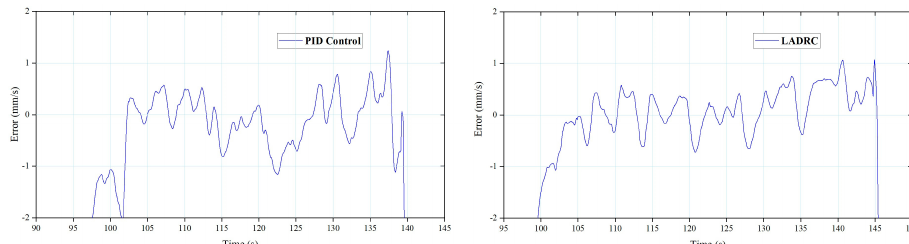
Figure 32. Speed error of cylinder #6 during unfolding.